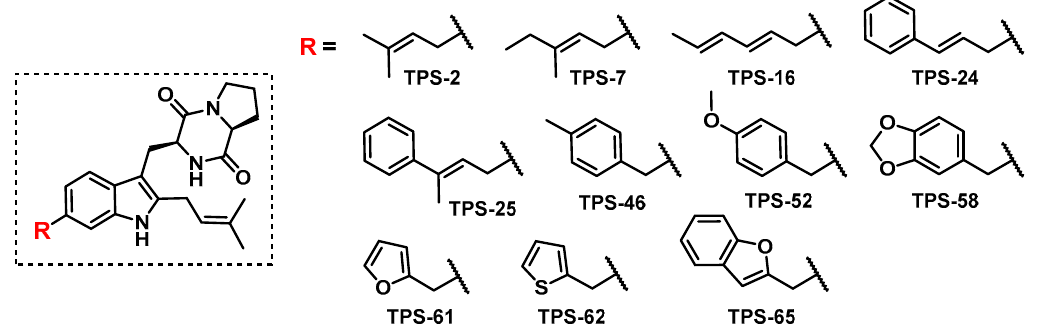
Figure 5. NMR ‐ characterized structures of alkyl ‐ TPS ‐ B analogs, where the number following TPS Figure 5. NMR-characterized structures of alkyl-TPS-B analogs, where the number following TPS represents the corresponding alkyl ‐ PP used in the reaction. Alkyl ‐ PP analogs 2, 7, 61, and 62 produced represents the corresponding alkyl-PP used in the reaction. Alkyl-PP analogs 2, 7, 61, and 62 produced 10–20% C ‐ 5 alkylated product. The regioisomers for TPS ‐ 2 , TPS ‐ 7 , and TPS ‐ 61 were separated by 10–20% C-5 alkylated product. The regioisomers for TPS-2 , TPS-7 , and TPS-61 were separated by semi ‐ preparative RP ‐ HPLC; however, TPS ‐ 62 remained inseparable. (See Supplementary Material). semi-preparative RP-HPLC; however, TPS-62 remained inseparable. (See Supplementary Materials).